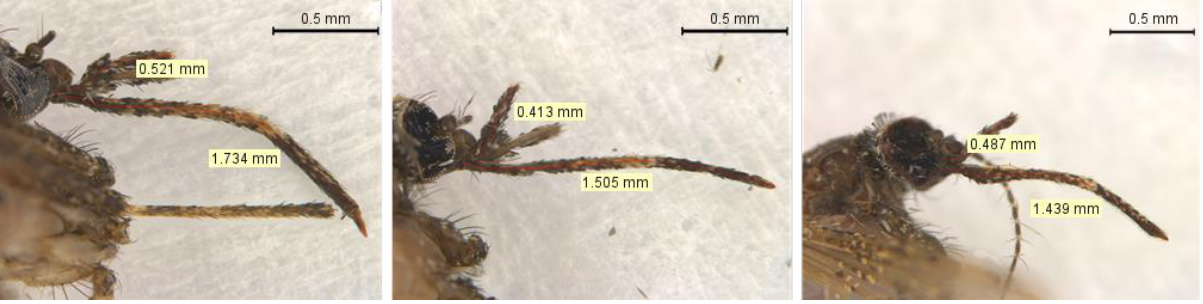
Figure 3. Head of three specimens of Mansonia pseudotitillans (IDs A7206A, A7206B e A7208) show- ing maxillary palpus with 0.33, 0.36 and 0.29 of the total proboscis length.